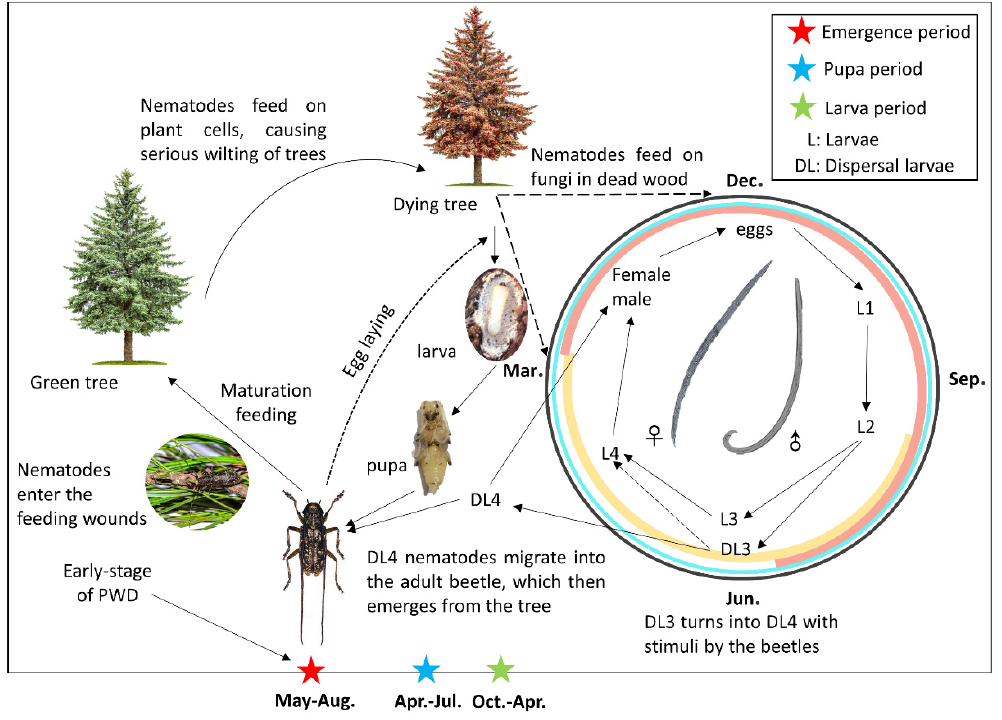
Figure 2. The process of pine wood nematode infection.